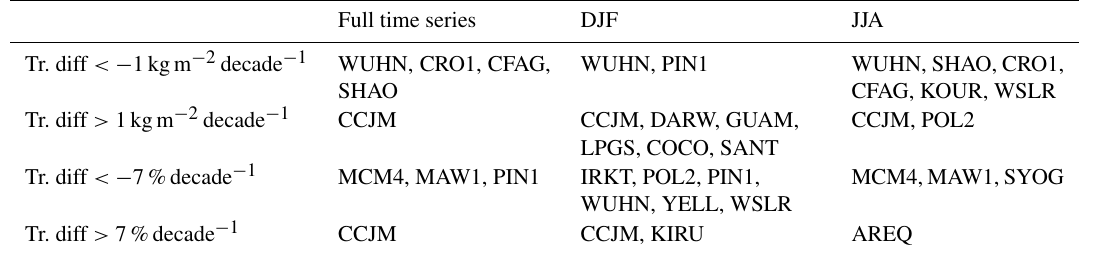
Table B1. Stations with most intense trend differences (ERAI − GPS) computed from time-matched GPS and ERA-Interim IWV